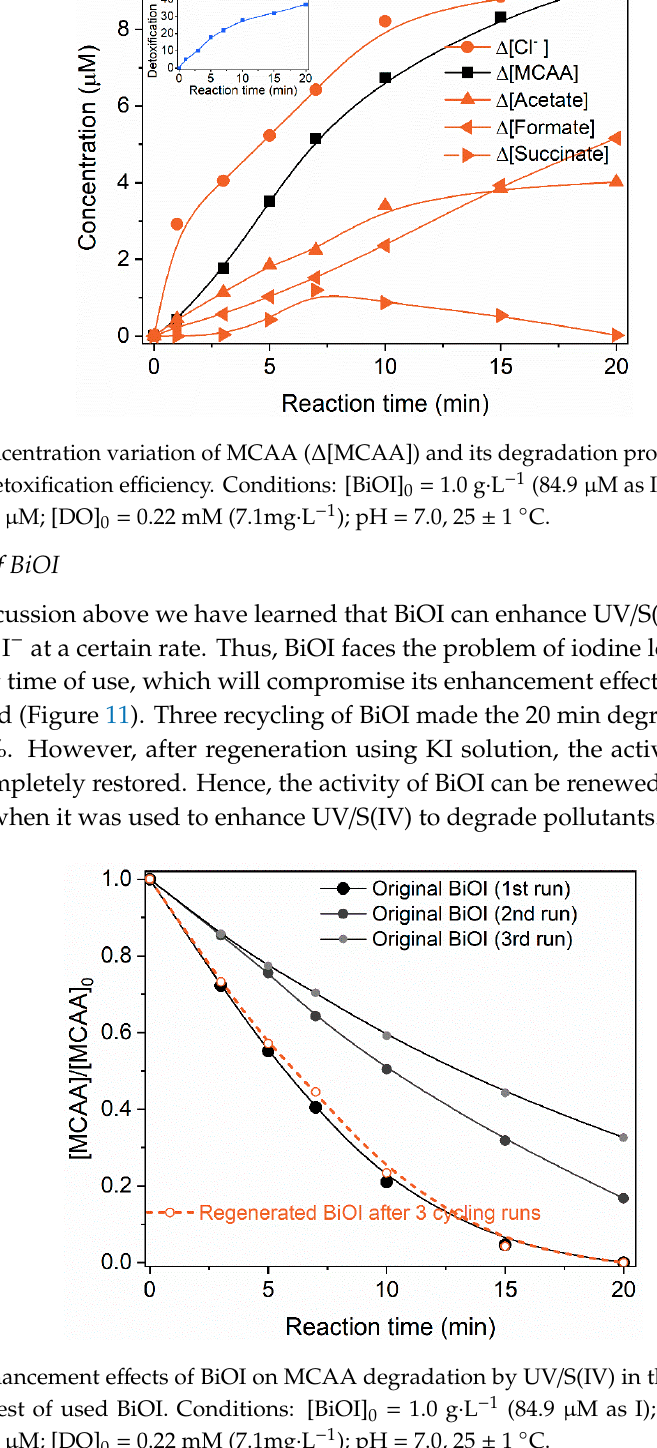
Figure 9. Concentration variation of sulfur species during degradation of MCAA by UV/S(IV) combined with BiOI. Conditions: [BiOI] 0 = 1.0 g ⋅ L − 1 (84.9 μ M as I); [S(IV)] 0 = 1.0 mM; [MCAA] 0 = 10